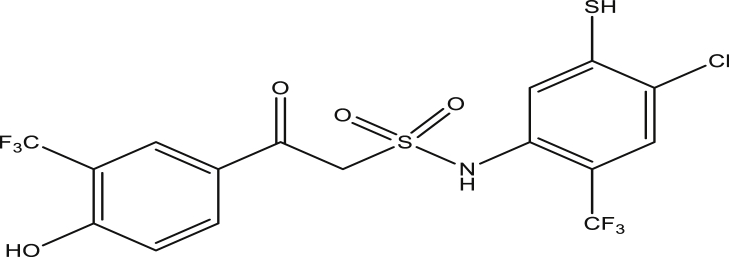
Compound 9h [N-(4-chloro-5-mercapto-2-(trifluoromethyl)phenyl)-2-(4-hydroxy-3-(trifluoromethyl)phenyl)-2-oxoethanesulfonamide (pEC500.3187280)].